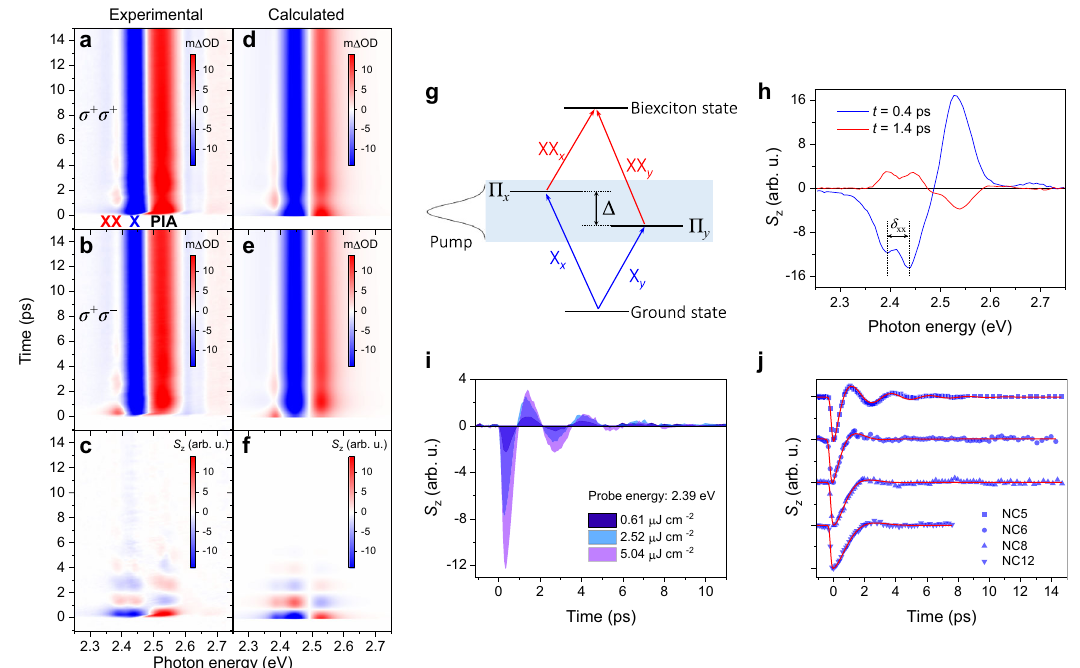
Fig. 2 | Exciton quantum beating in CsPbBr 3 NCs upon resonant excitation at ~12K. a Contour plot of the time-resolved CTA spectra with co-circular con fi g- uration ( σ + pump and σ + probe). XX, X, and PIA refer to the biexciton absorption, excitonbleaching,andphoto-inducedabsorption,respectively. b CTAspectrawith counter-circular con fi guration ( σ + pump and σ − probe). c The exciton quantum beating map, which is the subtraction of σ + σ + by σ + σ − CTA spectra. d , e , and f the calculated CTA spectra corresponding to a , b , and c , respectively. g Schematic diagramofafew-levelquantumsystemandopticaltransitions,whereX x/y andXX x/y